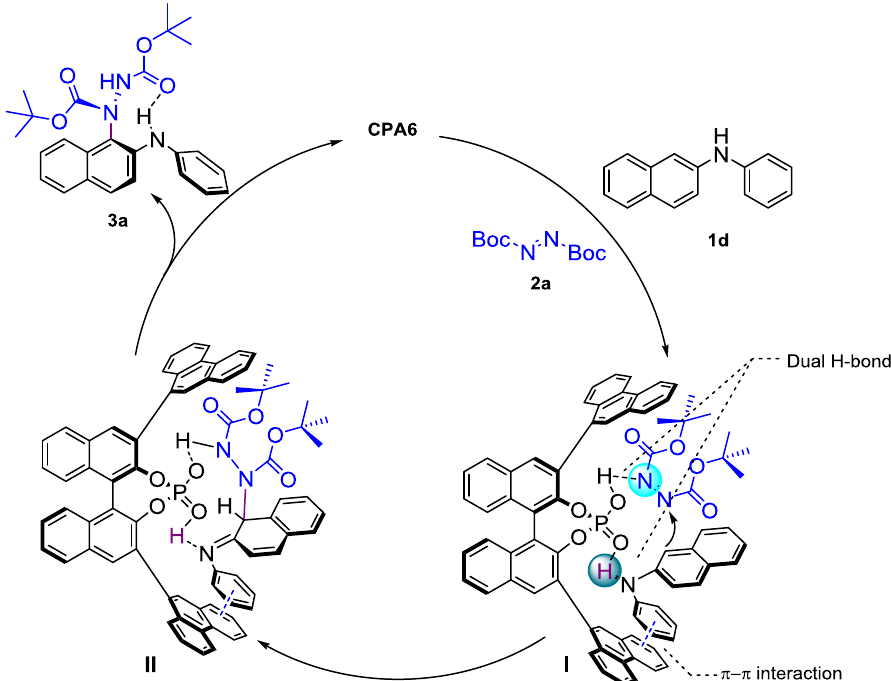
Fig. 3 Proposed reaction mechanism. The mechanism was described citing 1d as an example